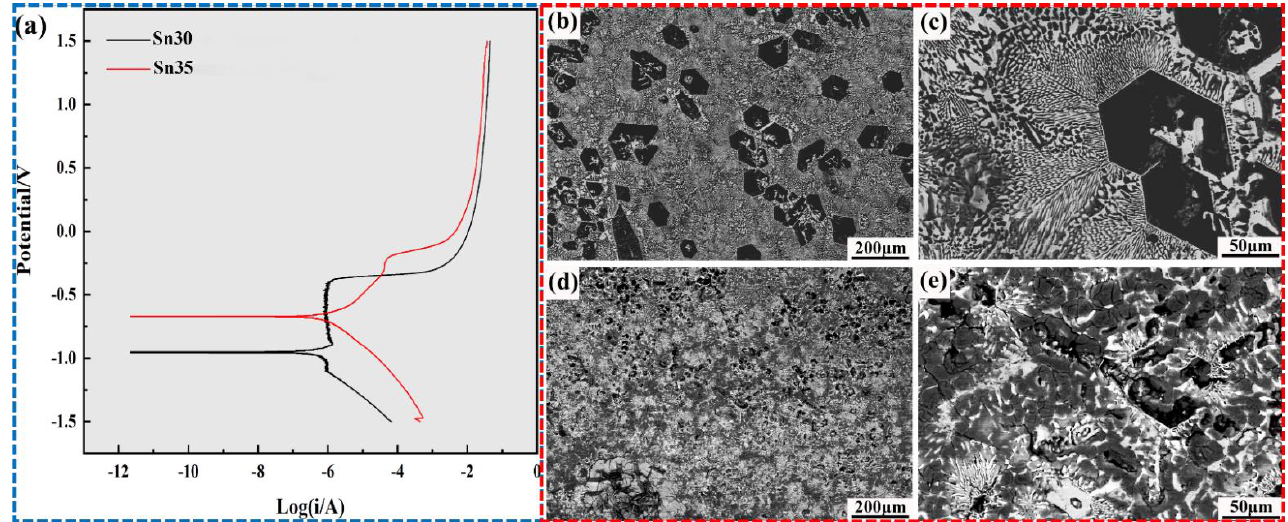
Figure 10. Corrosion properties characterization for Sn30 BHEA and Sn35 BHEA: ( a ) potentiodynamic polarization curves, ( b , c ) corrosion morphology of Sn30 BHEA, ( d , e ) corrosion morphology of Sn35 BHEA. Table 4. The key electrochemical parameters of Sn30 BHEA and Sn35 BHEA.